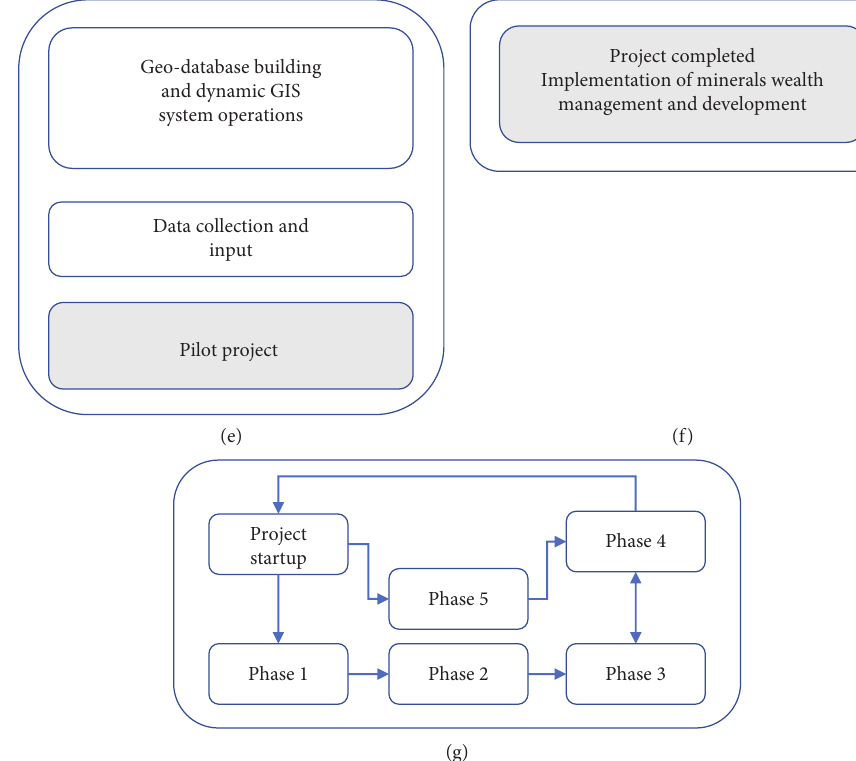
Figure 5: Generalization of GIS database implementation diagram. (a) Project startup. (b) Phase 1. (c) Phase 2. (d) Phase 3. (e) Phase 4. (f) Phase 5. (h) The whole GIS project diagram and flow